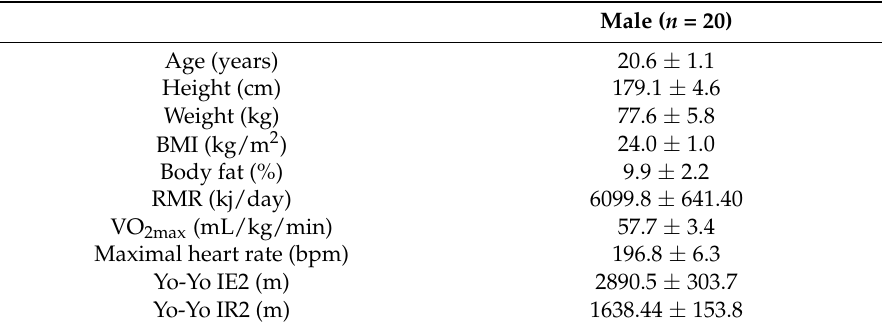
Table 1. Participants’ characteristics at